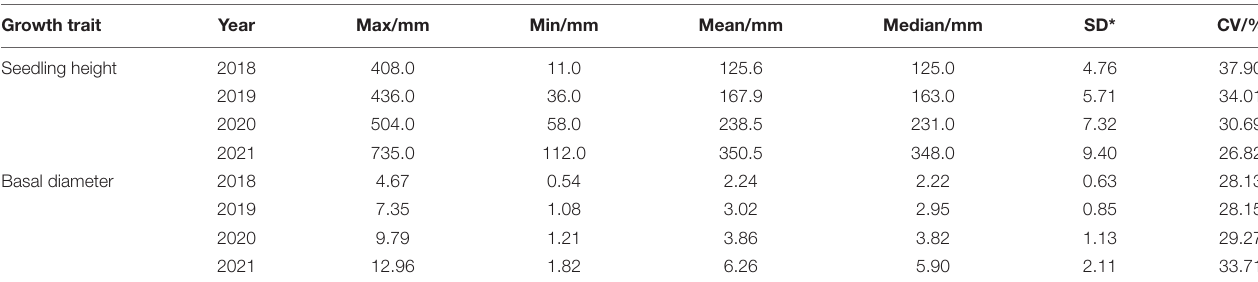
TABLE 3 | Variation analysis of phenotypic data in T. grandis .